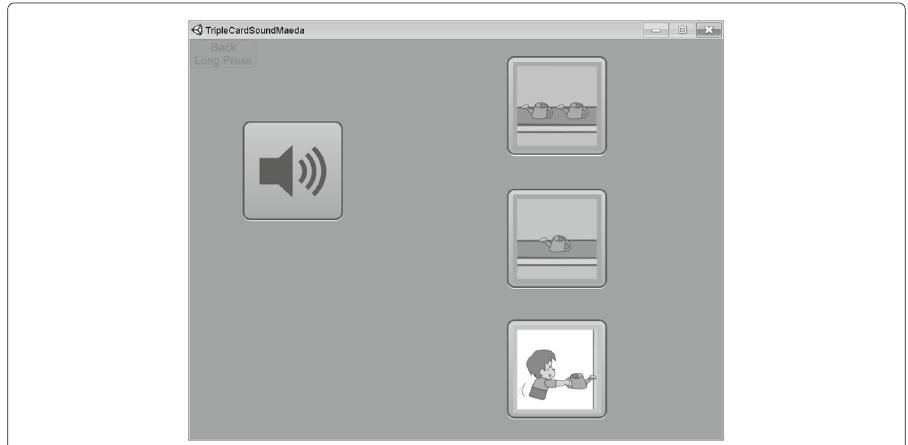
Fig. 3 Example of a problem in level 1. Screenshot of a level 1